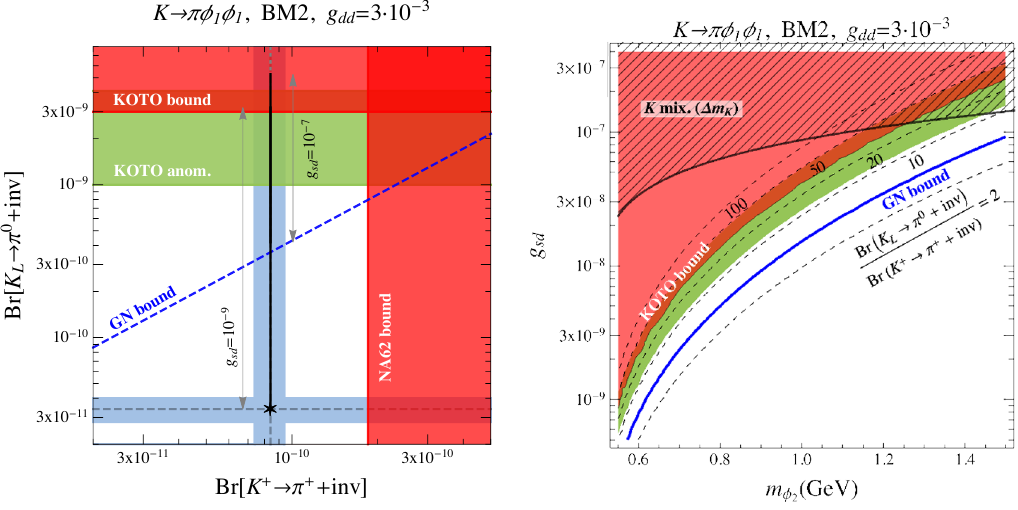
Figure 16 . The preferred parameter space for Model 2, BM2. The color coding is the same as in (cid:12)gure 15. For the model predictions (black lines) in the left panel we set g sd = 10 (cid:0) 9 ; 10 (cid:0) 7 and vary m (cid:30) [0 : 55 ; 1 : 5] GeV. 2 2